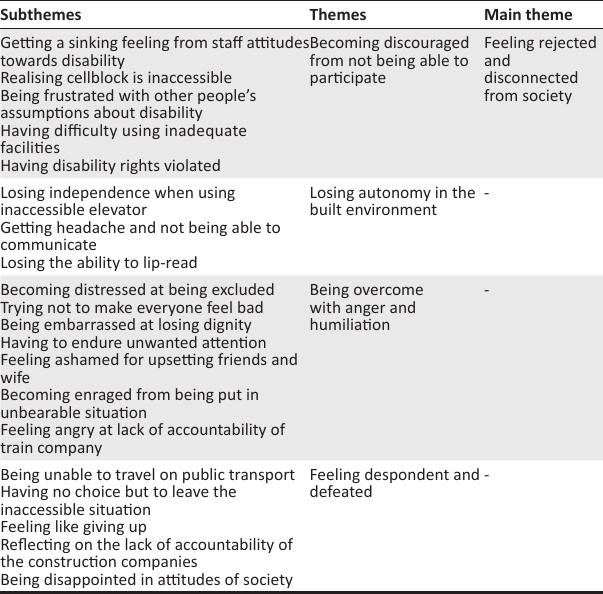
TABLE 3: Sub-themes, themes and main theme from the first structural analysis.